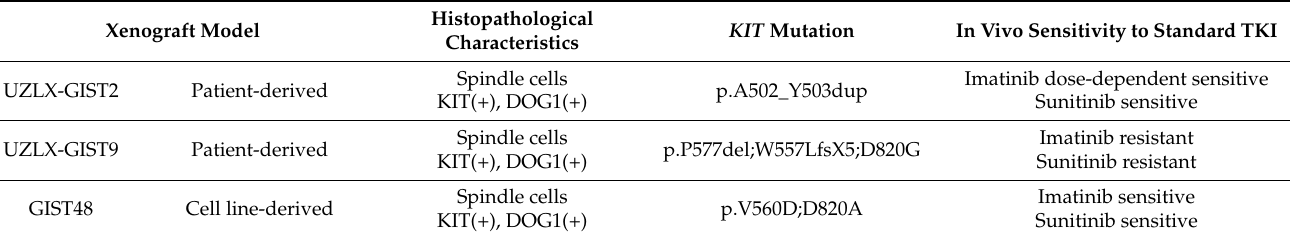
Table 1. Characterization of xenograft models used for the experimental